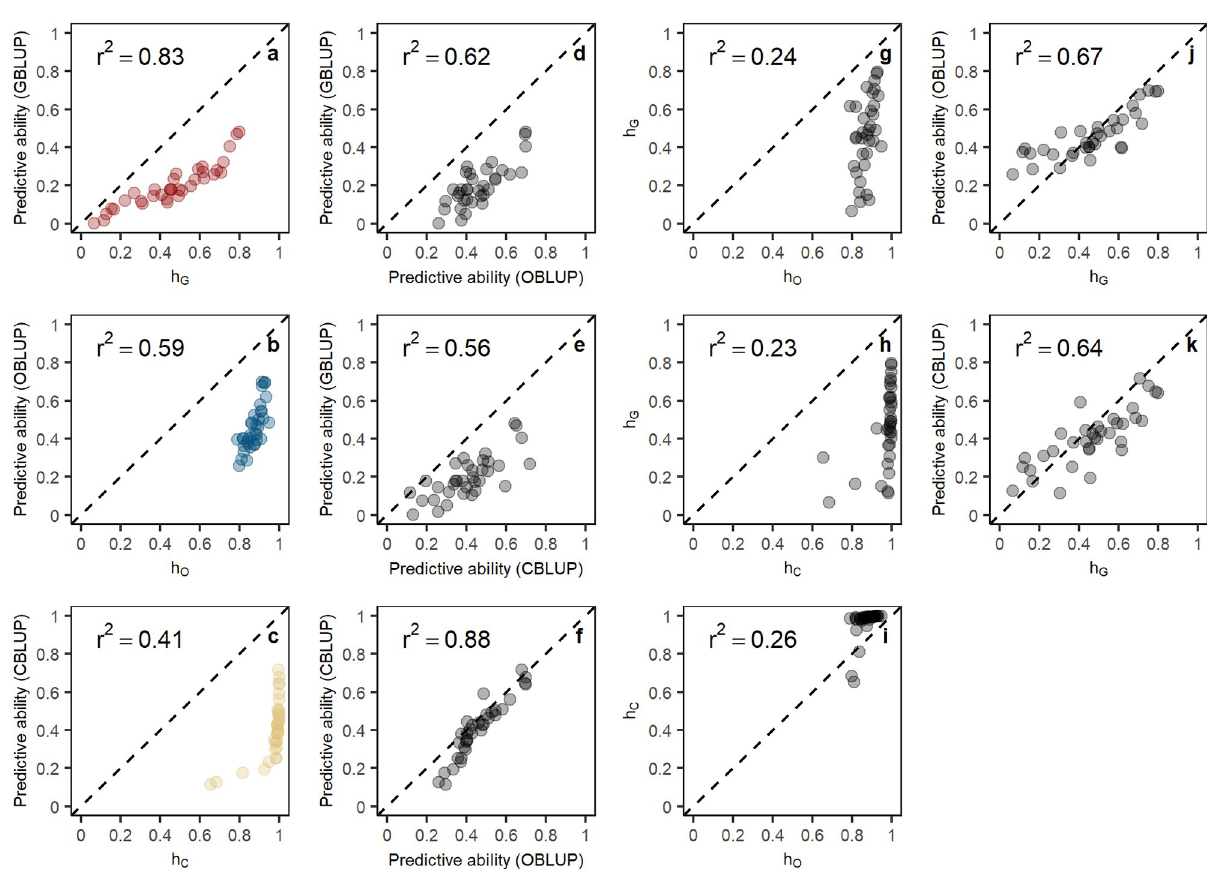
Fig 3. Correlations between predictive abilities and the square root of heritabilities. (a) The correlation between predictive abilities of GBLUP and the square root of SNP-based heritabilities across all traits; (b) The correlation between predictive abilities of OBLUP and the square root of ORF-based heritabilities across all traits; (c) The correlation between predictive abilities of CBLUP and the square root of CNO-based heritabilities across all traits; (d) The correlation between predictive abilities of GBLUP and predictive abilities of OBLUP across all traits; (e) The correlation between predictive abilities of GBLUP and predictive abilities of CBLUP across all traits; (f) The correlation between predictive abilities of CBLUP and predictive abilities of OBLUP across all traits; (g) The correlation between the square root of SNP-based heritabilities and the square root of ORF-based heritabilities across all traits; (h) The correlation between the square root of SNP-based heritabilities and the square root of CNO-based heritabilities across all traits; (i) The correlation between the square root of CNO-based heritabilities and the square root of ORF-based heritabilities across all traits; (j) The correlation between predictive abilities of OBLUP and the square root of SNP-based heritabilities across all traits; (k) The correlation between predictive abilities of CBLUP and the square root of SNP-based heritabilities across all traits; h , h , h represent the square root of SNP-based heritabilities, ORF-based G O C heritabilities, CNO-based heritabilities, respectively. r 2 depicts the coefficient of determination. The dots in the 9 panels depict the 35